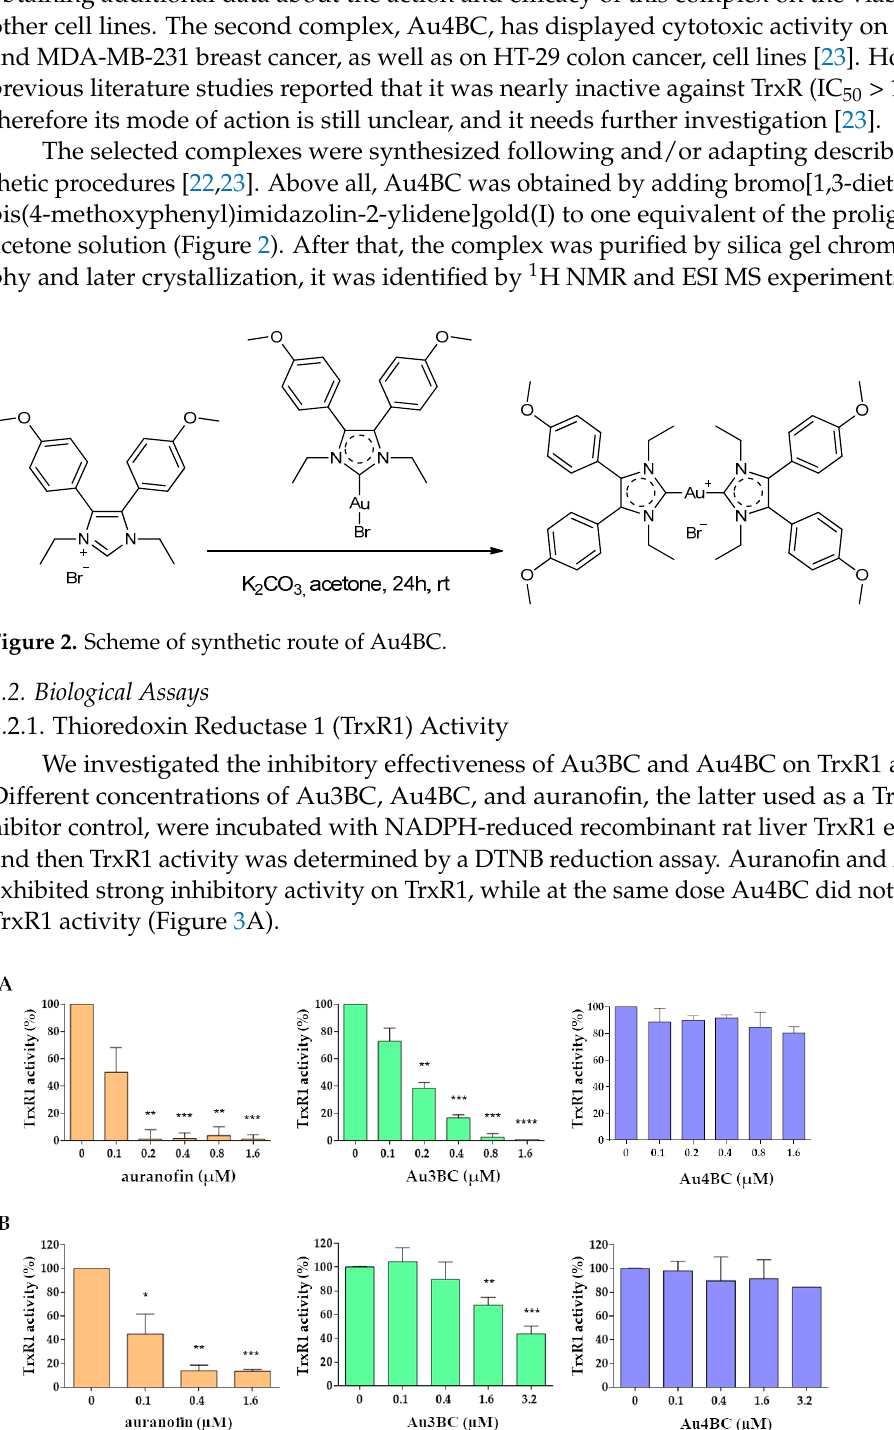
Figure 1. Chemical structures of the selected complexes Au3BC and Au4BC.